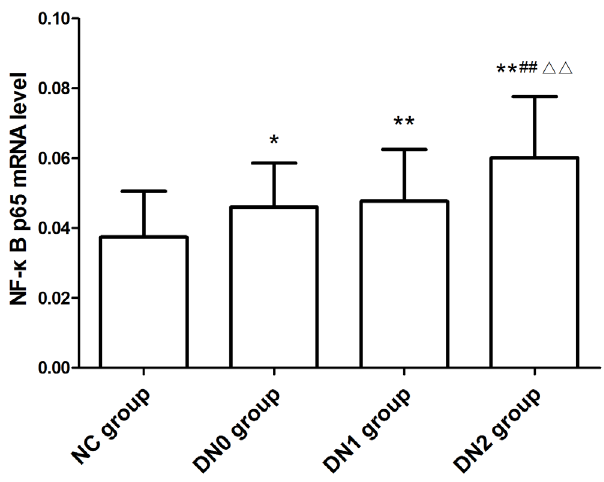
Figure 2. Nuclear NF- k B p65 mRNA level in peripheral blood mononuclear cells determined by real-time quantitative PCR.